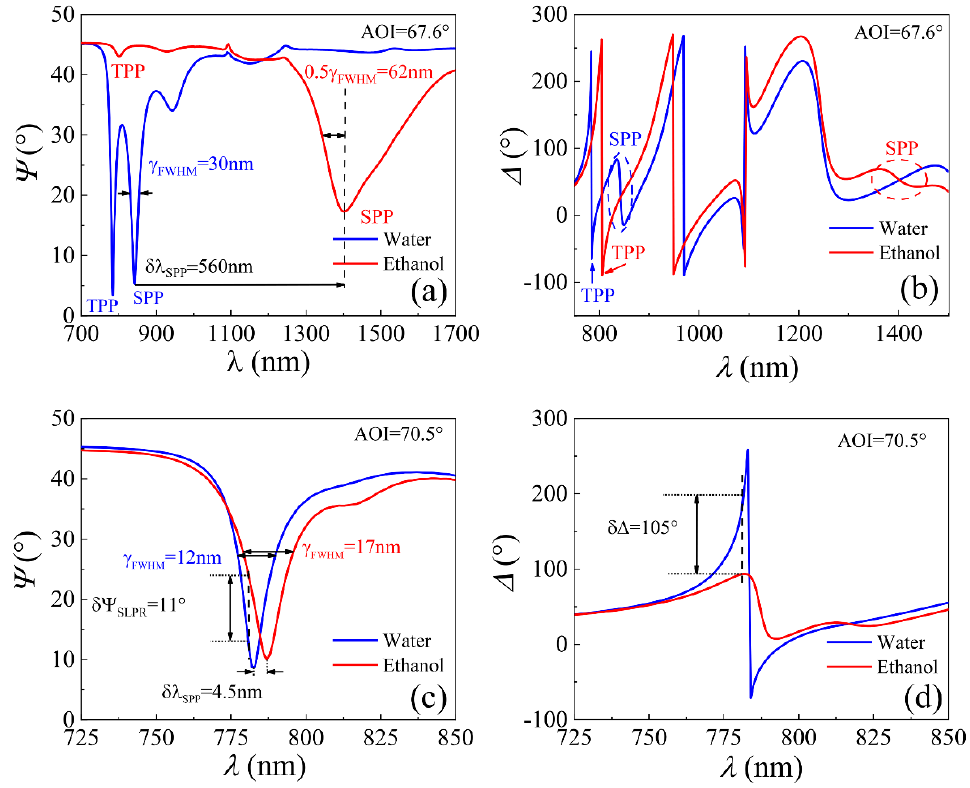
Figure 4. Spectra of ellipsometric parameters Ψ(λ) ( a , c ) and Δ(λ) ( b , d ) in both ambient, where the blue curve corresponds to water and the red curve to ethanol. The ellipsometric spectra for structure with thin gold layer ( a , b ), and for structure with gold nano-bumps ( c , d ). The dashed areas (blue and red) in figure ( b ) show the ellipsometric parameter Δ at the SPP position and the wavelength shift due to refractive index changes in different ambient.